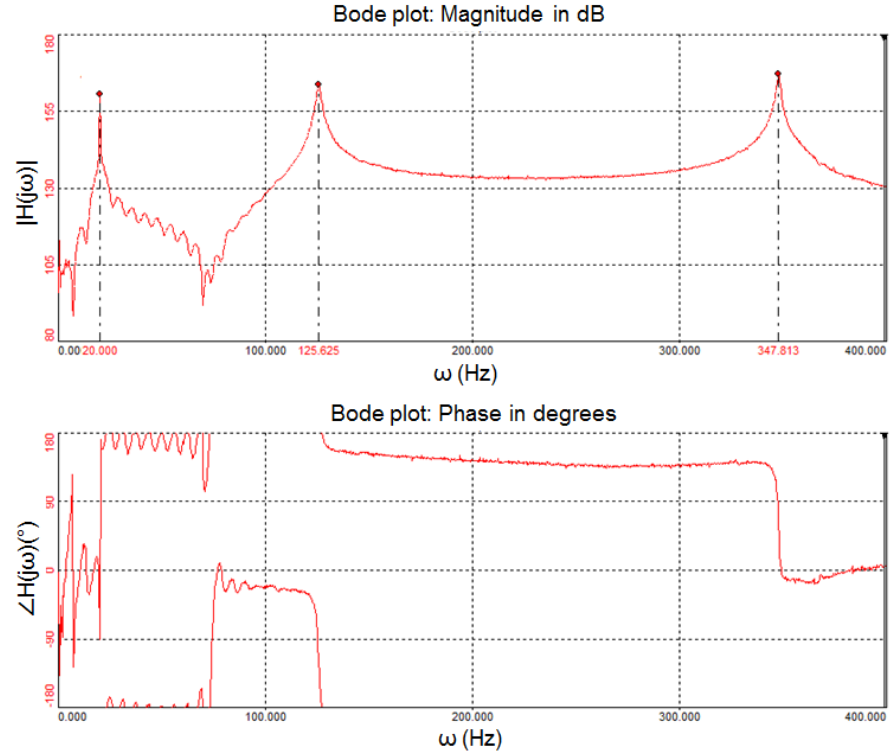
Figure 2. Accelerance frequency response function calculated in the experimental modal analysis of the cantilever